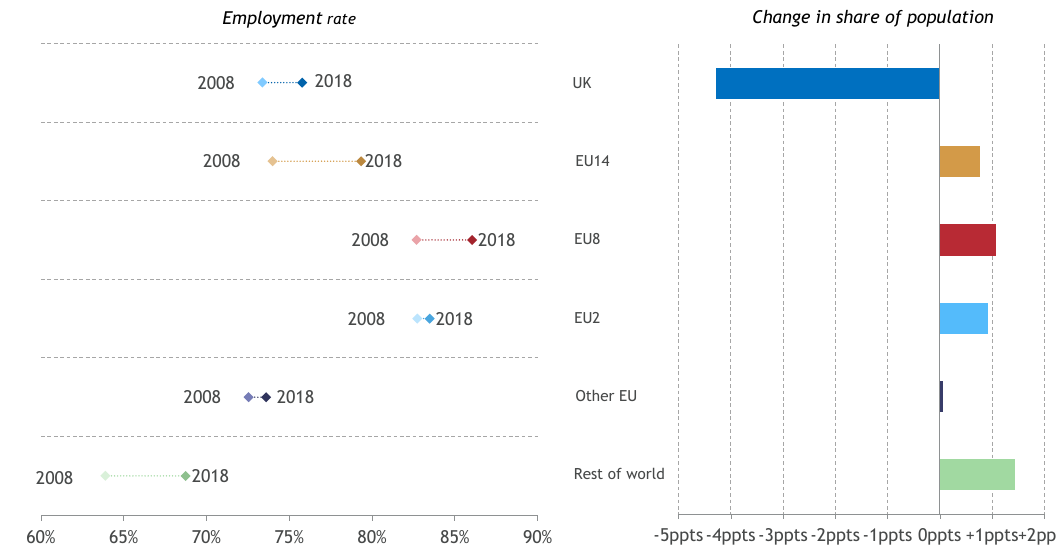
Source: RF analysis of ONS, Labour Force